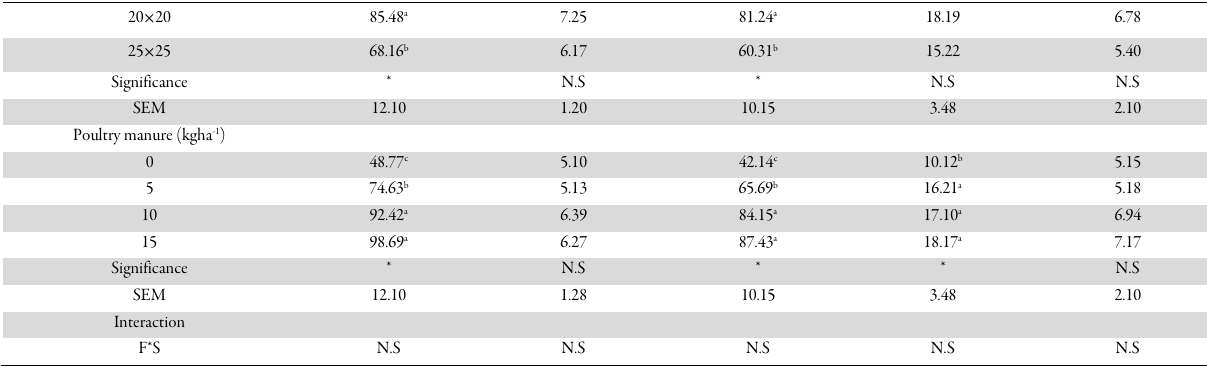
Table 7. Effect of poultry manure and spacing on nutrient uptake of onion bulb 20 × 20